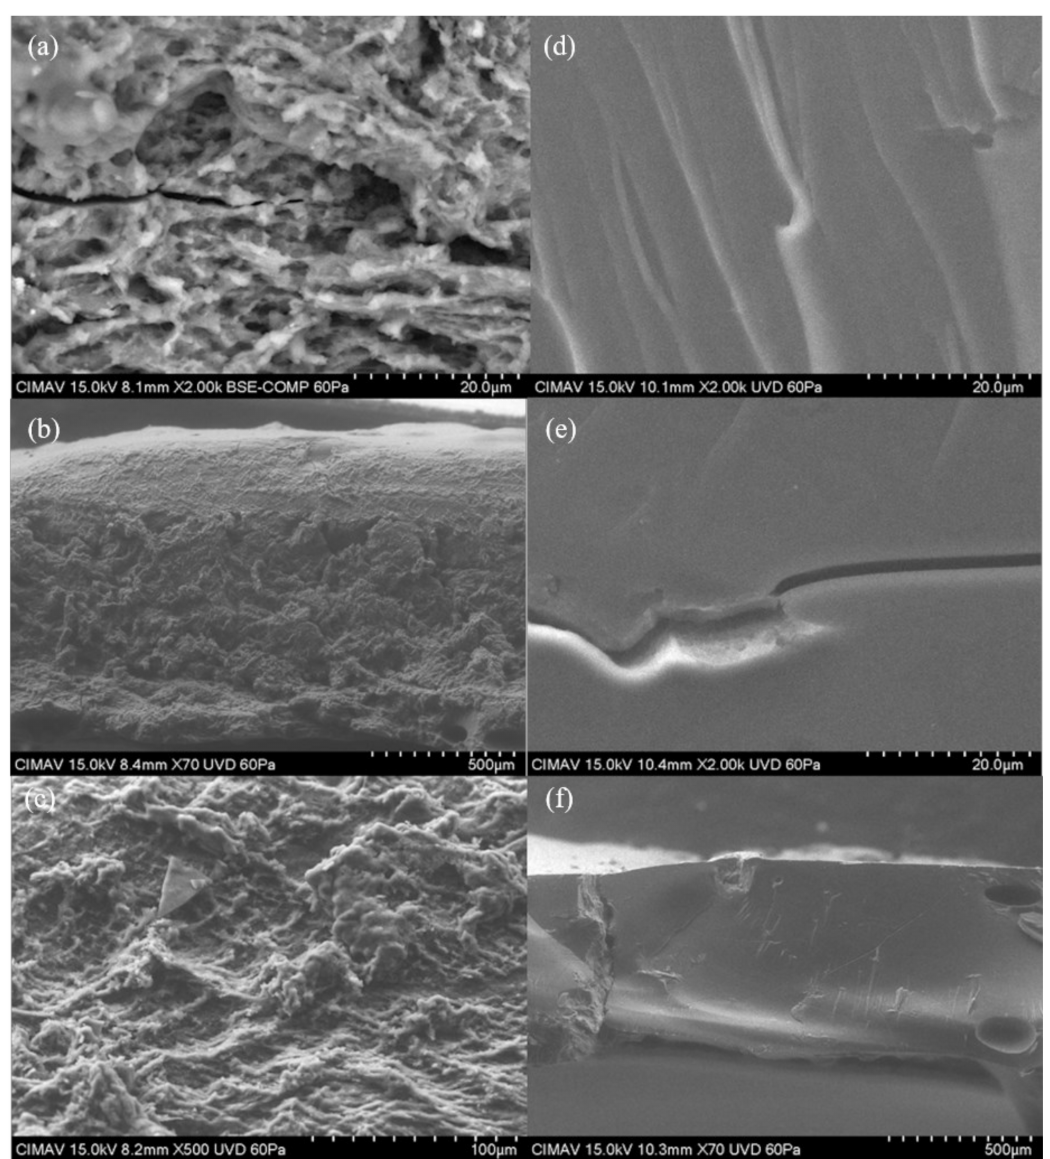
Figure 12. Micrographs of the product without expanding. Plate: ( a ) Formulation 1 (2000 × ), ( b ) Formulation 1 (70 × ), ( c ) Formulation 1 (500 × ), ( d , e ) Formulation 7 (2000 × ), ( f ) Formulation 7 (70 ×